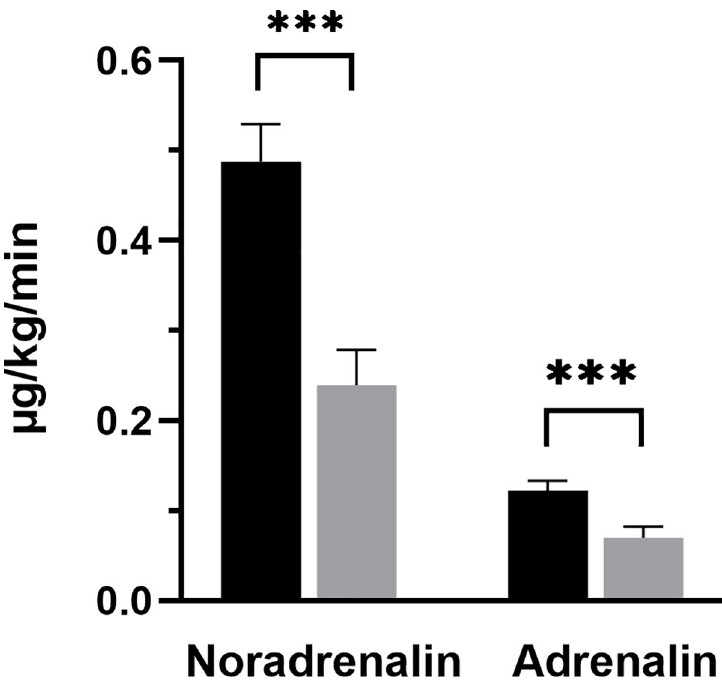
Fig 3. Noradrenalin and adrenalin requirement before and after cytokine adsorption. Graphs show mean noradrenalin and adrenalin requirement before and after cytokine adsorption. Data shows n = 71 patients (noradrenalin) and n = 56 patients (adrenalin). Error bars correspond to SEM. Asterisks mark differences between both groups at a significance ��� p < 0.001.